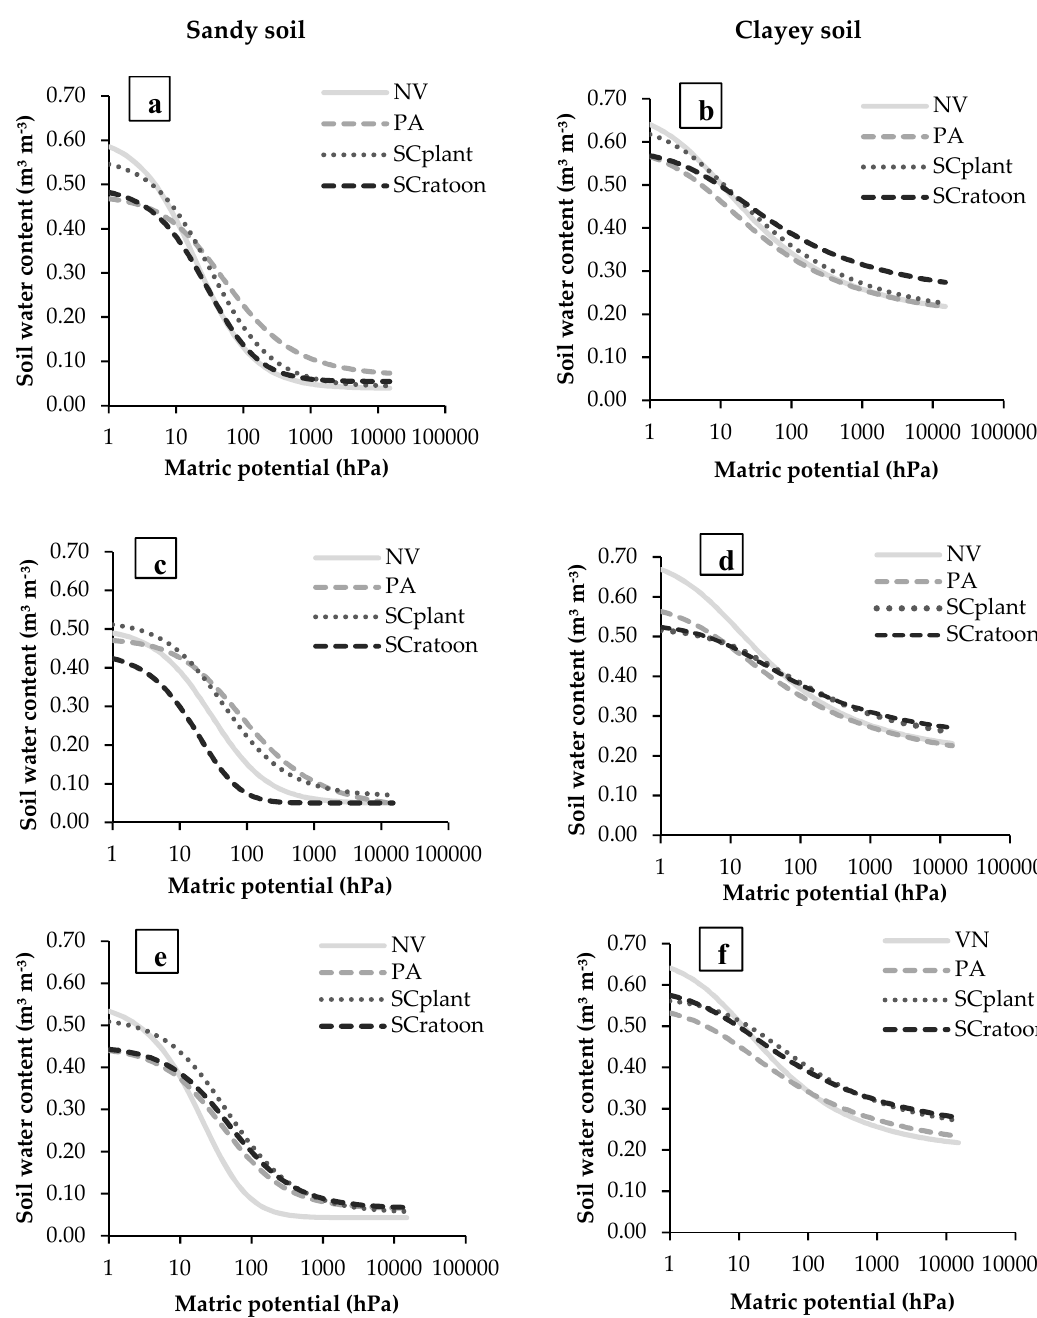
Figure 4. Average soil water retention curve (SWRC) from 0–10 ( a , b ), 10–20 ( c , d ), and 20–30 cm ( e , f ) layers under native vegetation (NV), pasture (PA), sugarcane plant (SCplant), and sugarcane ratoon (SCratoon) at Sandy soil ( a , c , e ) and Clayey soil ( b , d , f ).